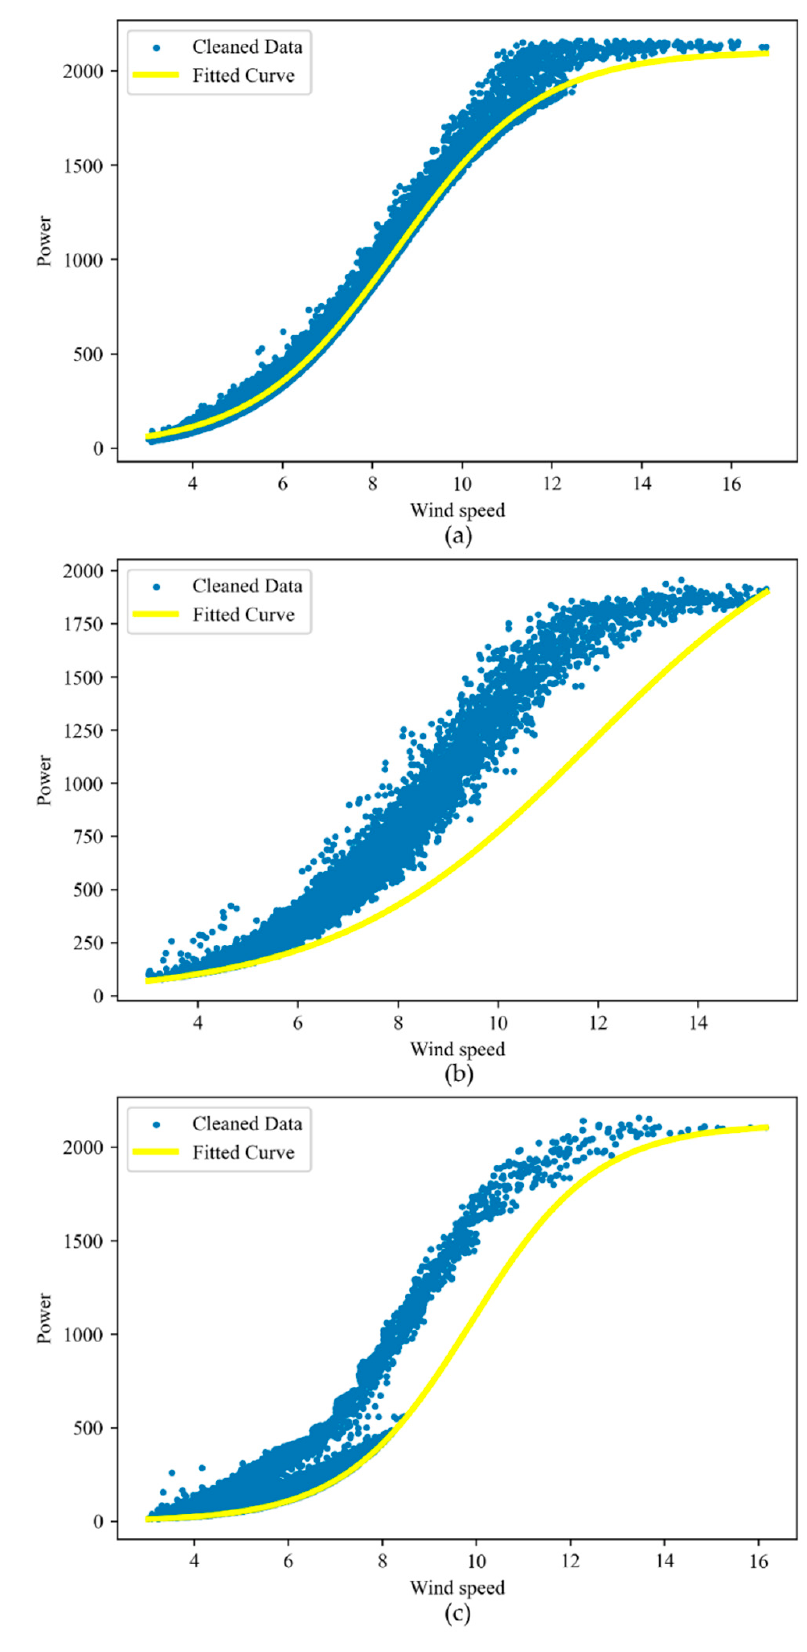
Figure 8. ( a ) #1 wind turbine; ( b ) #2 wind turbine; ( c ) #3 wind turbine.